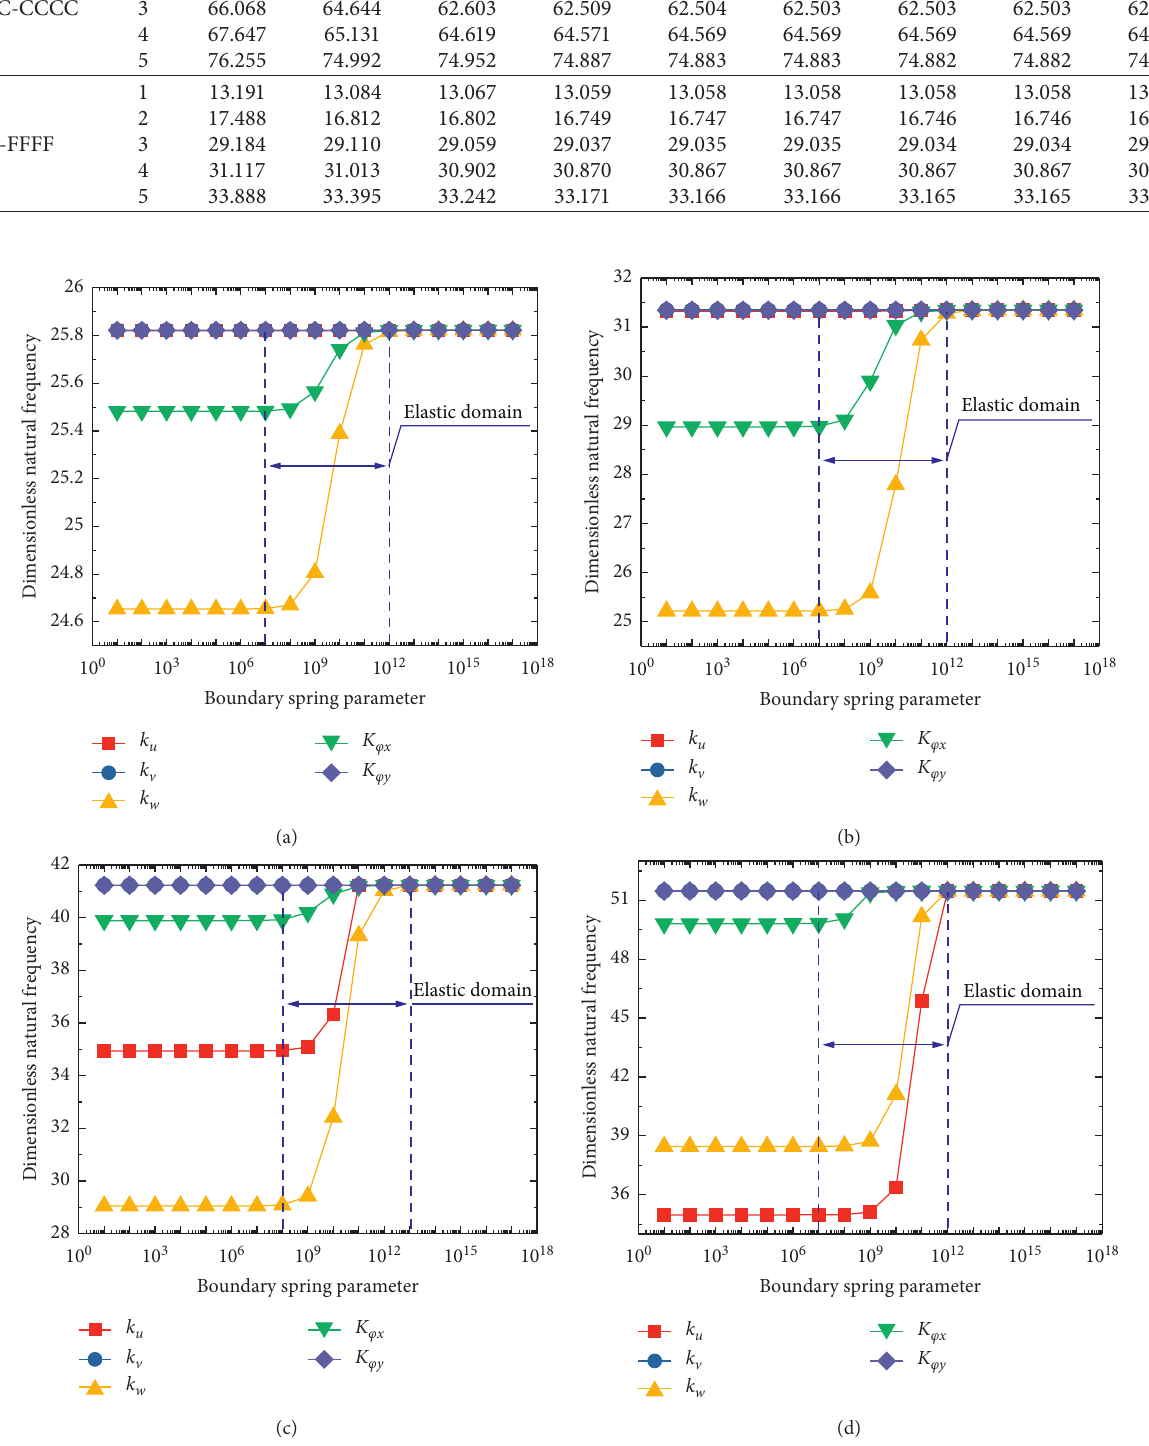
Figure 2: Variation of dimensionless natural frequency versus spring parameters for an LCDPS with different mode order. (a) 1st mode; (b) 2nd mode; (c) 3rd mode; (d) 4th